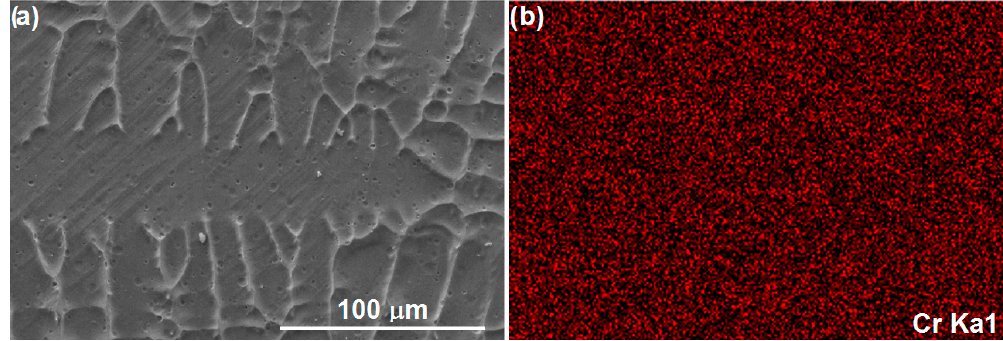
Figure 13. ( a ) SEM micrograph of the as ‐ chill cast Co ‐ 20 wt. % Cr directionally solidified alloy showing a part of columnar dendrites, ( b ) X ‐ ray mapping of Cr (chromium).